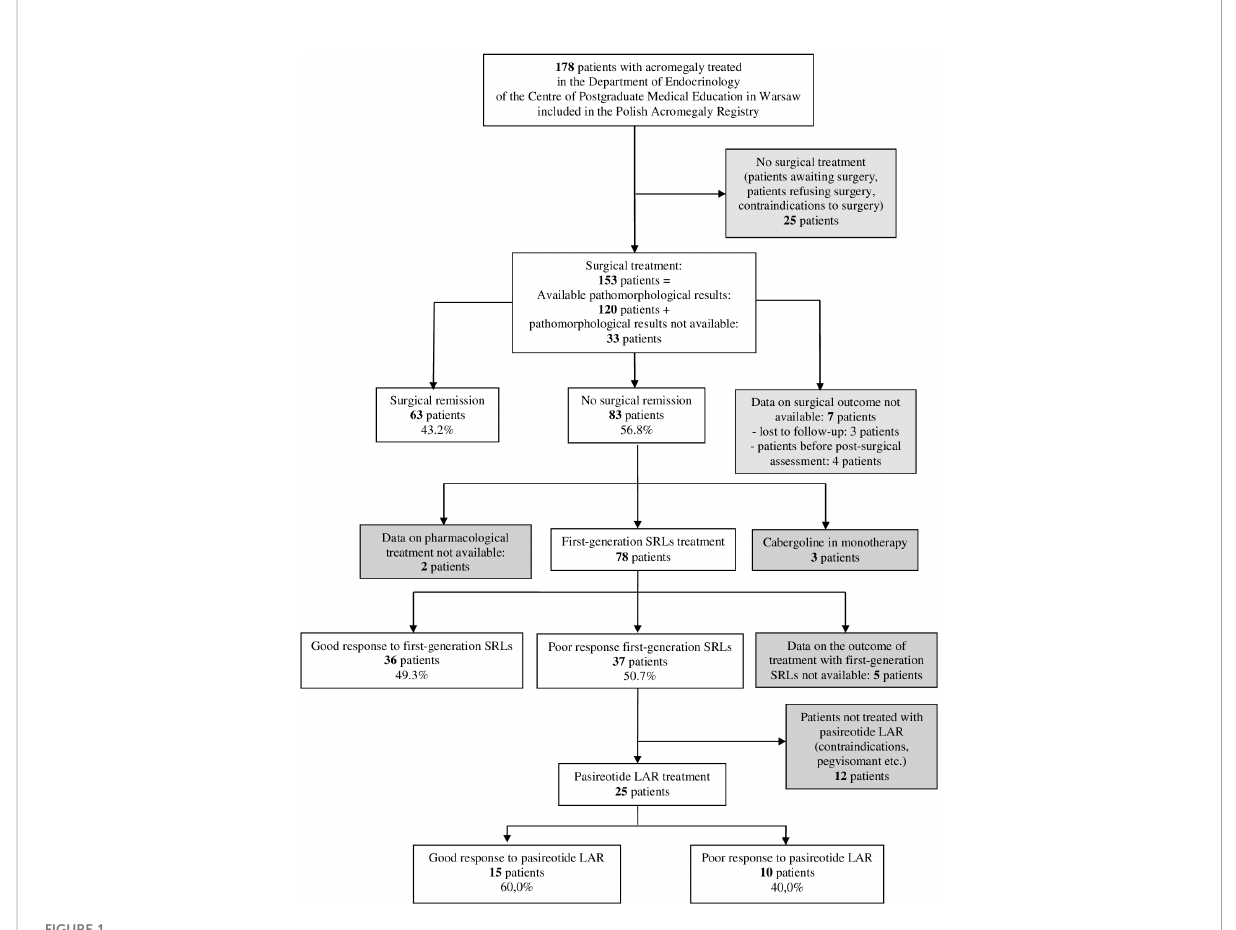
FIGURE 1 Flowchart of patients